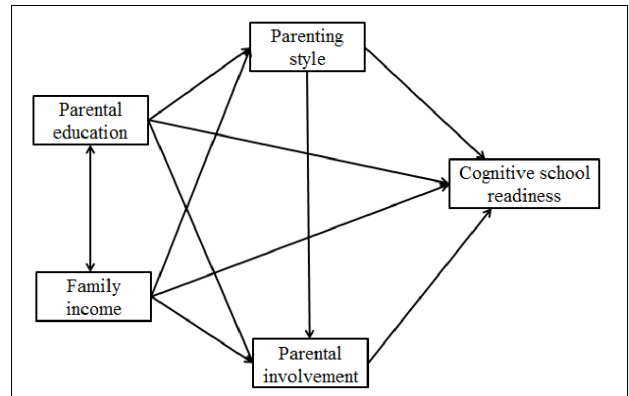
FIGURE 1 | The hypothesized model of the relation between parental education and family income and children’s cognitive school readiness, mediated through parenting style and parental